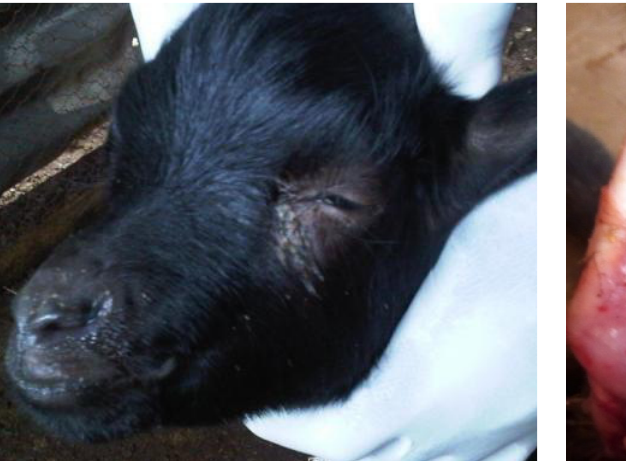
Fig. 1. Catarrhal nasal discharges Fig. 2. The oral cavity from a field case of PPR showing severe mucosal ulceration on the soft palate